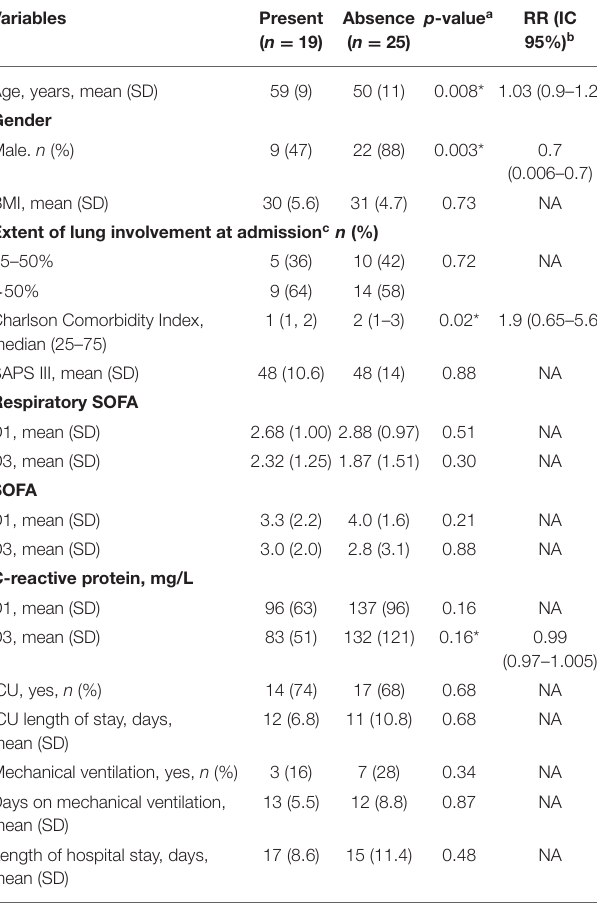
There was no association between MIP and mMRC scores. When desaturation on 6MWT, FEV1, DLCO, and CT lesions entered in a linear regression only FEV1 ( p = 0.017) and marginally DLCO ( p = 0.12) were associated with higher mMRC scores (R square for the model 0.32).